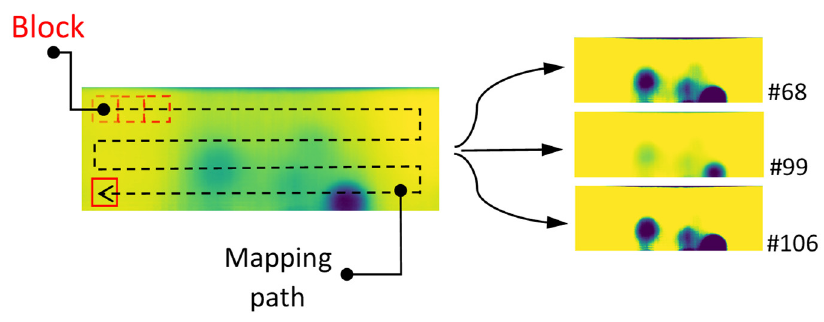
Figure 9. Improved DRR enhanced image selection across the Figure 8 original image.